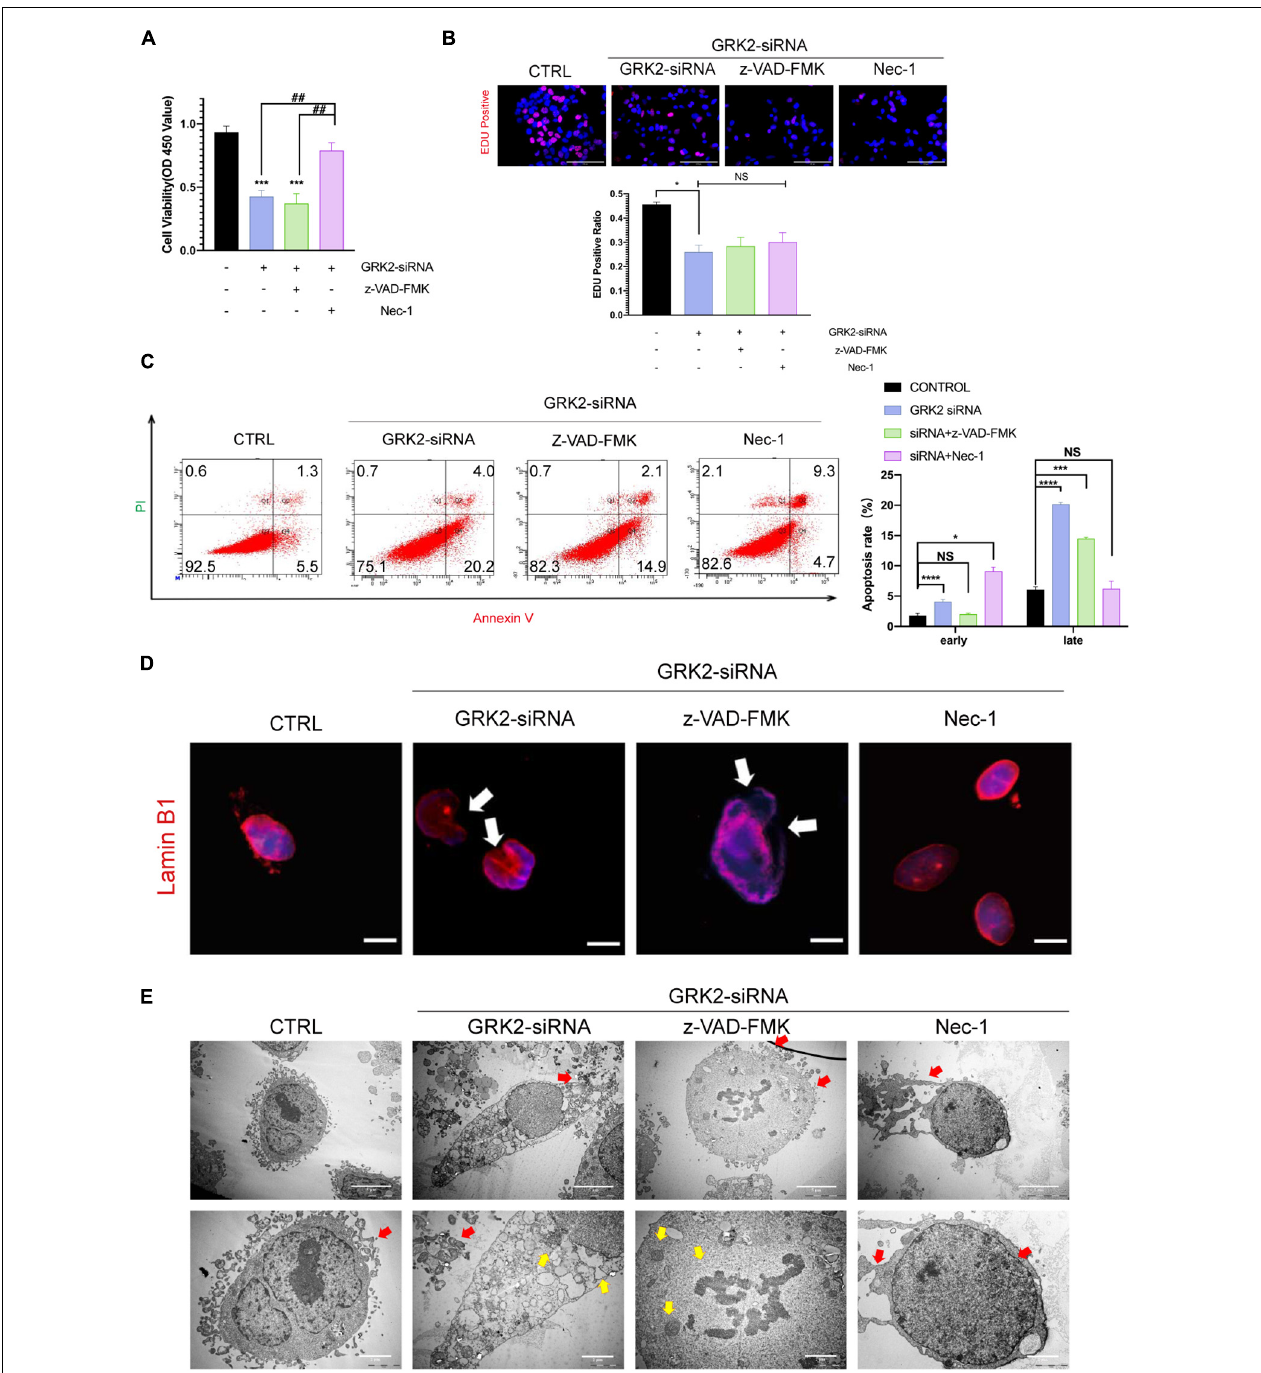
FIGURE 6 | Suppression of Necroptosis rescues nuclear rupture and DNA leakage induced by reduced GRK2 levels in HTR8/SVneo cells. (A) Treatment of necrostatin-1 (Nec-1) enhances cell viability in GRK2 knockdown HTR8/SVneo cells, while cells treated with z-VAD-FMK cannot improve survival rates. (B) EdU (magenta) and DAPI (blue) staining images for cell proliferation analysis in HTR8/SVneo cells. The proliferation rates of cells transfected with GRK2-siRNA remain the same administration with/without z-VAD-FMK (25 µ M, 12 h) or nec-1 (30 µ M, 12 h). Scale bar, 100 µ m. (C) Combined Annexin-V and PI staining was used to distinguish early apoptotic (Annexin-V + /PI − ) and late apoptotic/necrotic cells (Annexin-V + /PI + ). (D) Microscopy images demonstrated considerable nuclear deformation mediated by GRK2 knockdown. White arrows indicate distorted or ruptured sites of nuclear envelope. Scale bar, 10 µ M. (E) Transmission electron microscopy (TEM) images show nuclear envelope breakdown (yellow arrow) and cell content outflow (red arrow) in HTR8/SVneo cells. The upper to bottom, 2,000 × and 5,000 × magnification, respectively. NS, not significant; * P < 0.05, *** P < 0.001, and **** P < 0.0001 versus control group; ## P < 0.01 versus GRK2-siRNA